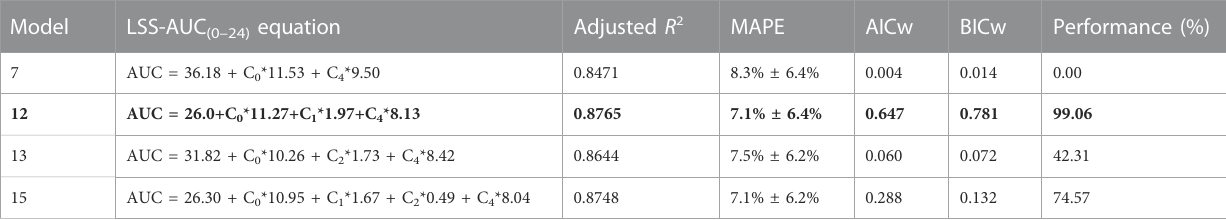
TABLE 3 Limited sampling equations with adjusted r 2 higher than 0.799. MAPE, AIC weight, BIC weight and performance percentage are shown. The LSS with the best performance has been highlighted in bold. Model